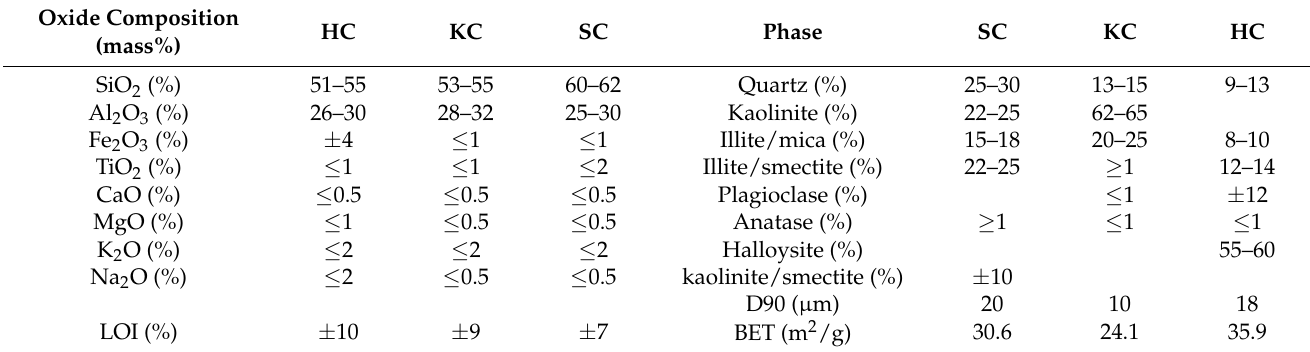
Figure 8. The particle size of waste glass ( a ) and fine sand ( b ). Table 2. Chemical and mineralogical composition of clays and